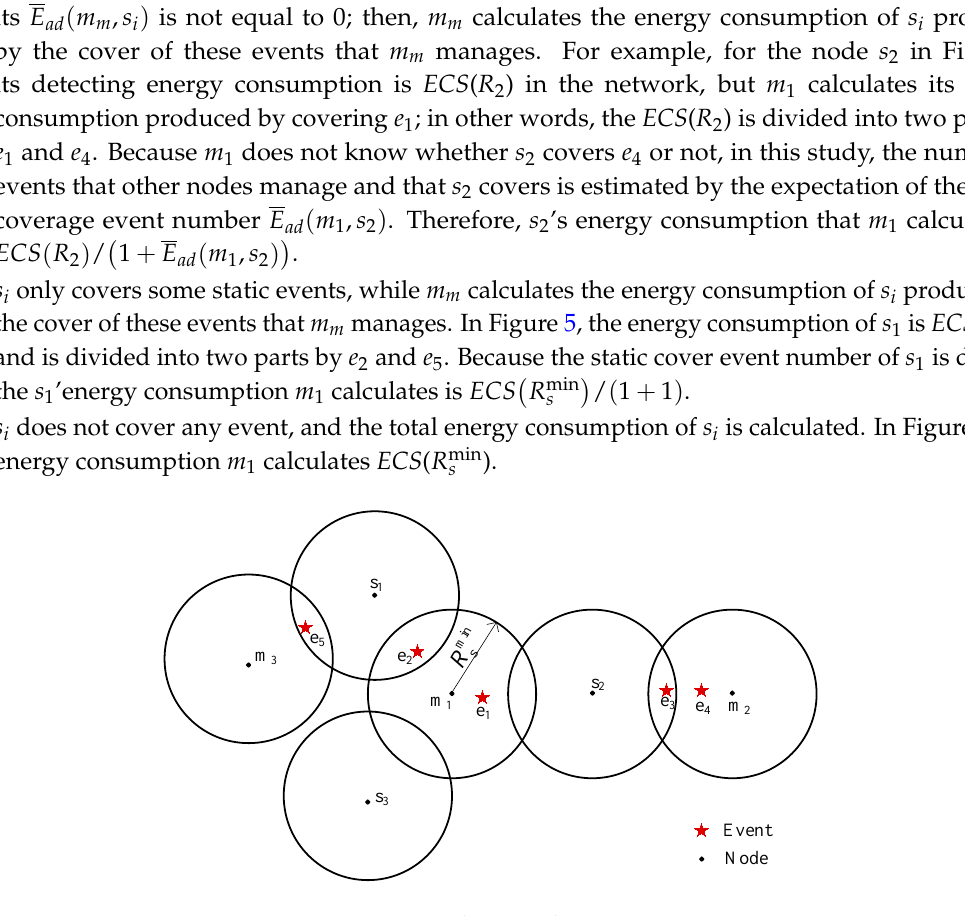
Figure 5. Schematic diagram.